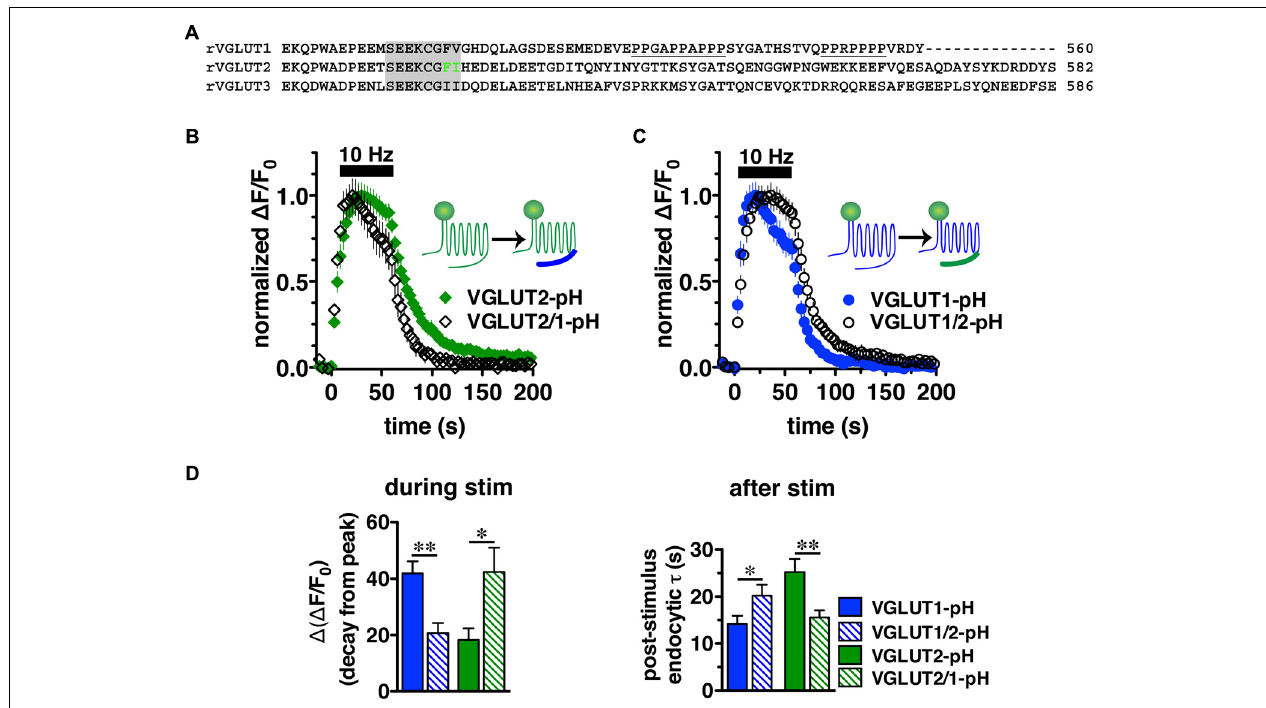
FIGURE 4 | Vesicular glutamate transporter C-termini direct isoform-specific trafficking. (A) Alignment of putative targeting sequences in the C-termini of rat VGLUT1, 2, and 3 downstream of the last transmembrane spanning region. Dileucine-like motifs (shaded) are conserved among the three isoforms. The F 518 I 519 motif of VGLUT2 is in green. Polyproline domains (underlined) are present only in VGLUT1. (B) Swapping the C-terminal tails of the two VGLUT-pHs produces chimeric VGLUT2/1-pH and VGLUT1/2-pH (insets). Replacing the VGLUT2 C-terminus with the VGLUT1 C-terminus results in a faster time course of fluorescence change of the chimeric VGLUT2/1-pH (black, n = 8) relative to wild-type (WT) VGLUT2-pH (green, n = 9). (C) Conversely, replacing the VGLUT1 C-terminus with the VGLUT2 C-terminus results in a slower time course of fluorescence change of the chimeric VGLUT1/2-pH (black, n = 8) relative to WT VGLUT1-pH (blue, n = 11). (D) Quantification shows that the extent of fluorescence decay from peak fluorescence [ (cid:49) ( (cid:49) F/F 0 )] during stimulation (left panel) is greater and the rate of endocytosis after stimulation (right panel) of VGLUT2/1-pH (hatched green) is faster than WT VGLUT2-pH (green), similar to that of WT VGLUT1-pH (blue). Likewise, fluorescence decay for the chimeric VGLUT1/2-pH (hatched blue) is lower than WT VGLUT1-pH (blue), and more similar to WT VGLUT2-pH (green). Data are means ± SEM of (cid:49) F/F 0 , acquired every 3 s, normalized to total fluorescence and to peak fluorescence in each trace during stimulation. Data are from at least 18 synapses per coverslip from 8 to 11 coverslips from at least three independent cultures, ∗ p < 0.05, ∗∗ p <